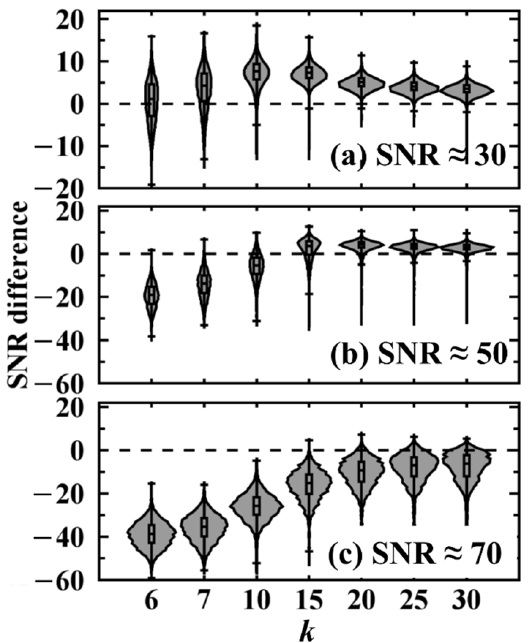
Figure 9. SNR difference of the proposed algorithm under different k value.